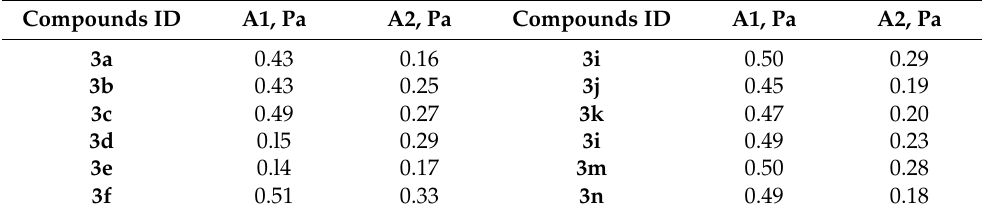
Table 1. Predicted biological activity spectra for the studied